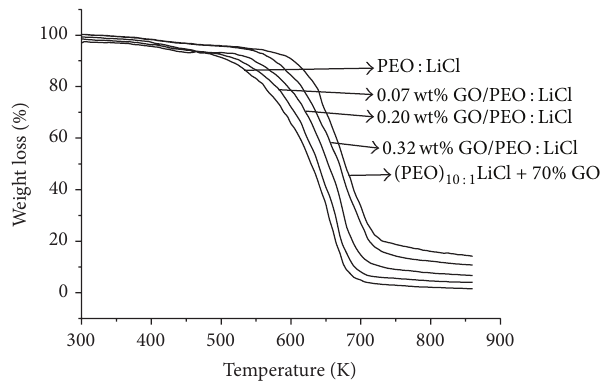
Figure 2: SEM of (A) pure PEO, (B) pure graphene, and (C) 1.4wt% GO/PEO system.